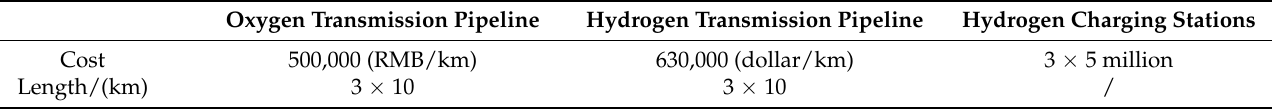
Table 6. Pipeline and hydrogen charging station parameters.